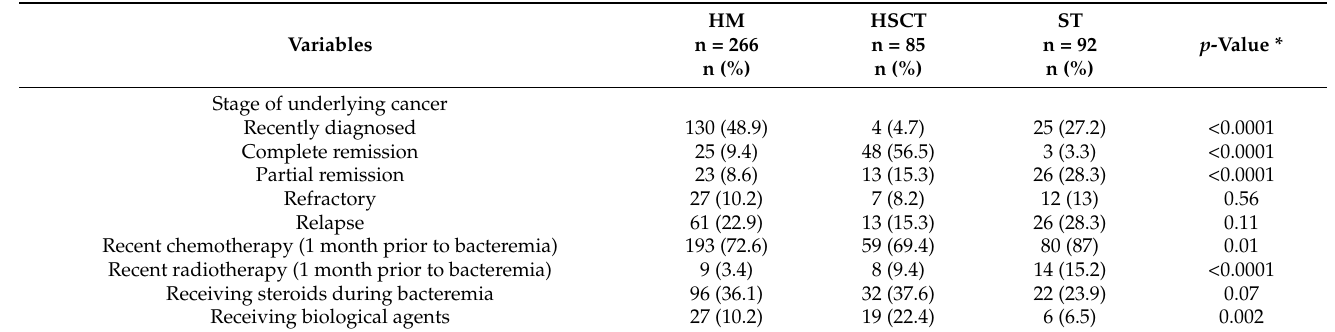
Table A2. Stage of underlying cancer and immunosuppression in ST, HM and HSCT